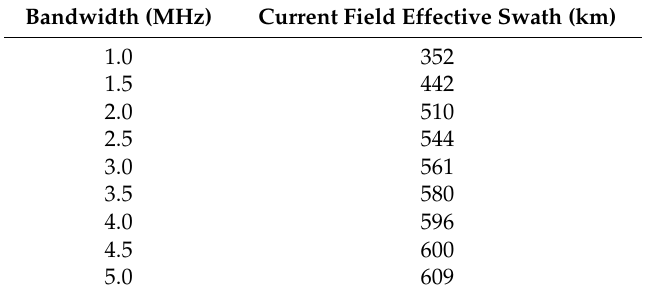
Figure 16. Surface current velocity components Std with bandwidths for a wind speed of 7 m/s and a wind direction of 90°: ( a ) along-track direction; ( b ) cross-track direction. Table 6. Current field effective swaths (current velocity Std of 0.15 m/s) with different bandwidths. Bandwidth